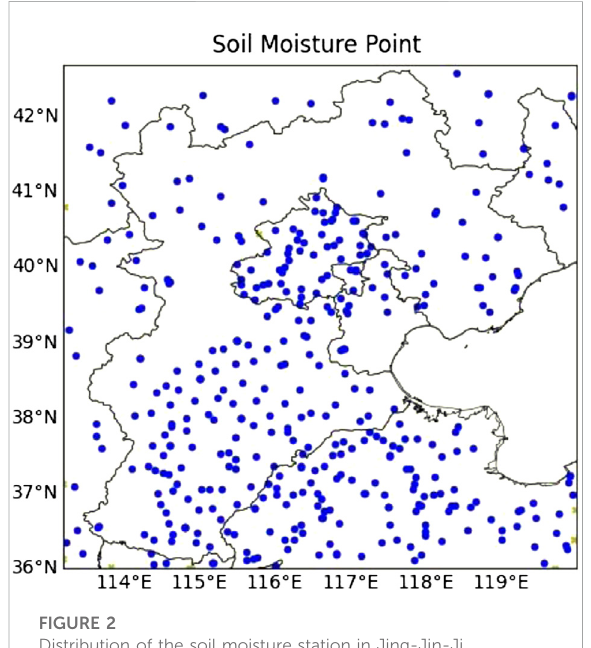
FIGURE 2 Distribution of the soil moisture station in Jing-Jin-Ji.